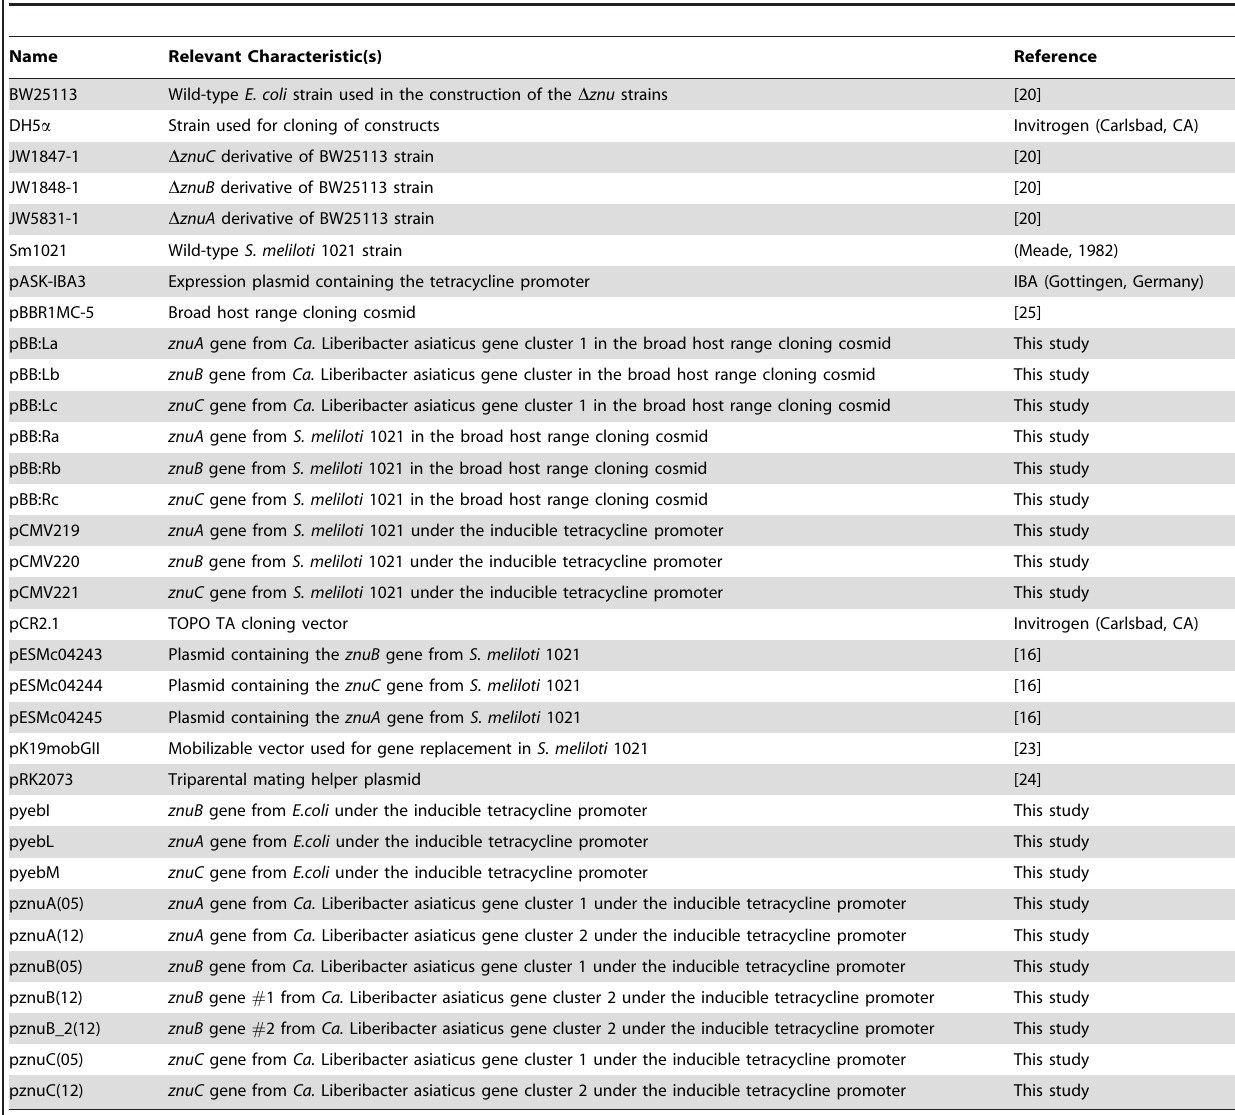
Table 1. Plasmids and strains used in this